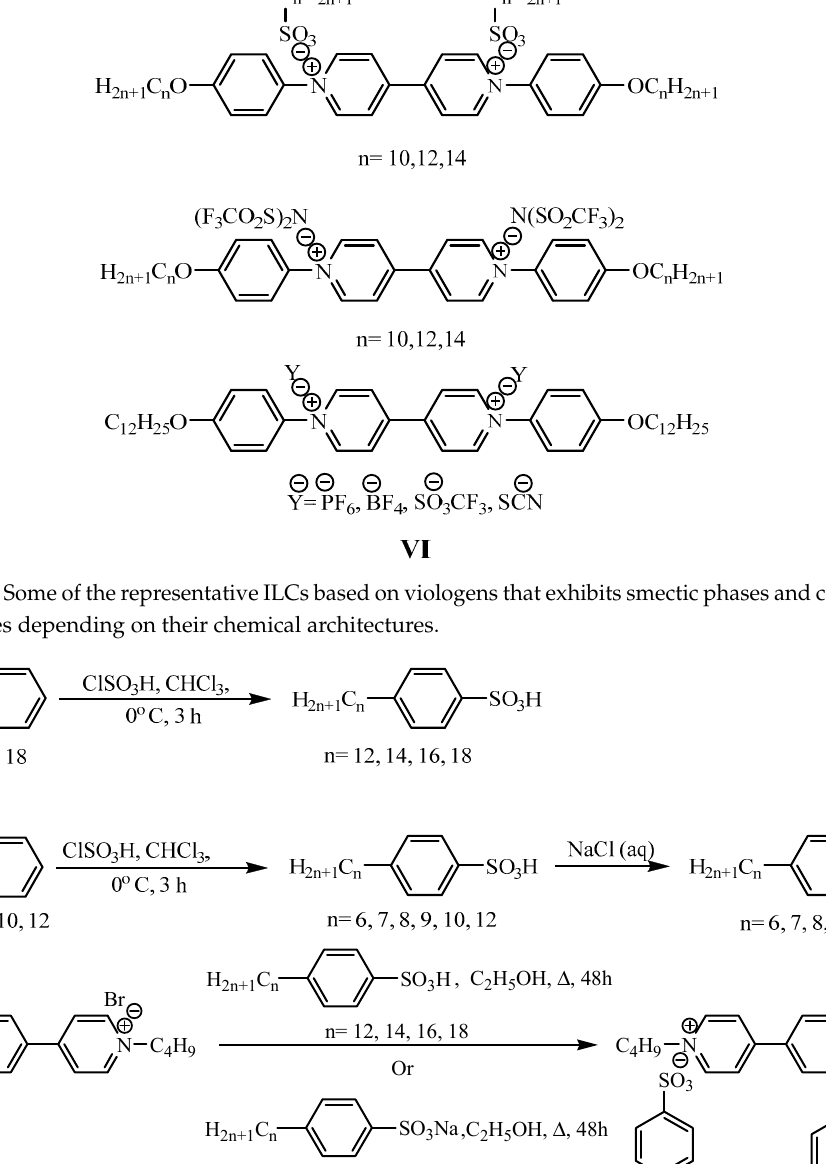
Figure 1. Some of the representative ILCs based on viologens that exhibits smectic phases and columnar LC phases depending on their chemical